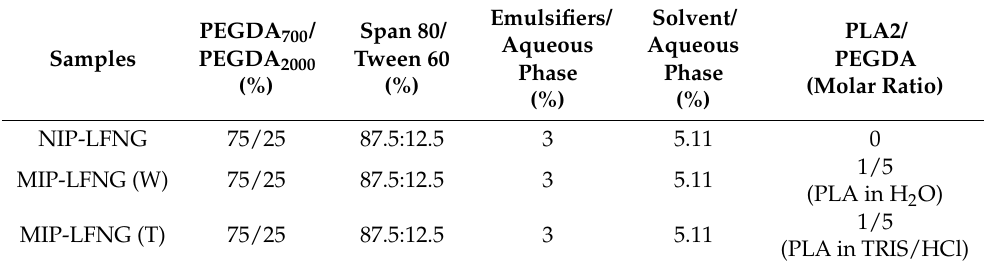
Table 1. The synthesis recipes for